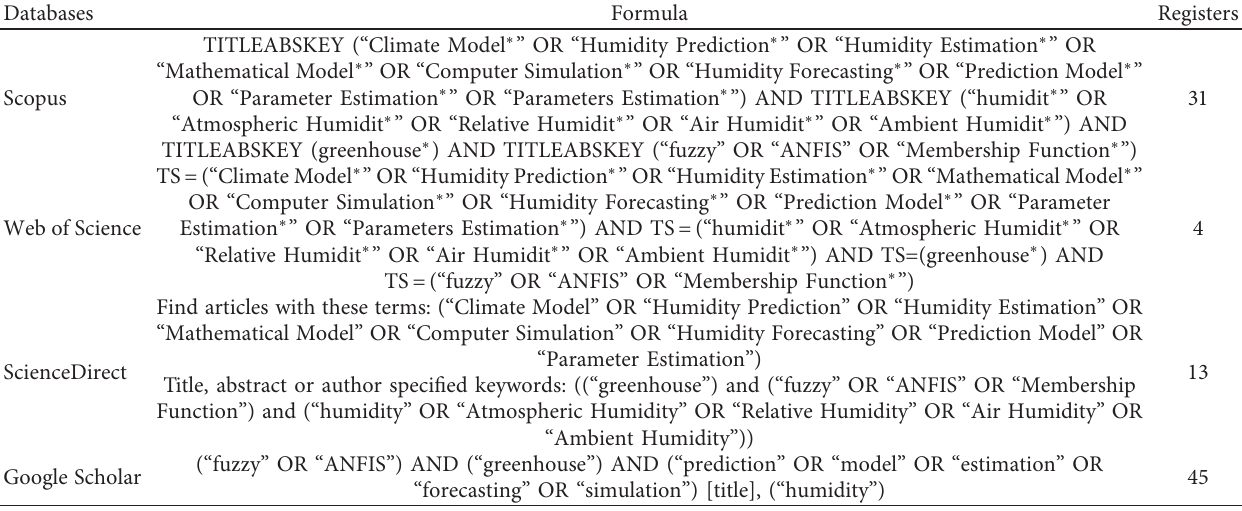
Table 1: Consulted databases and their search